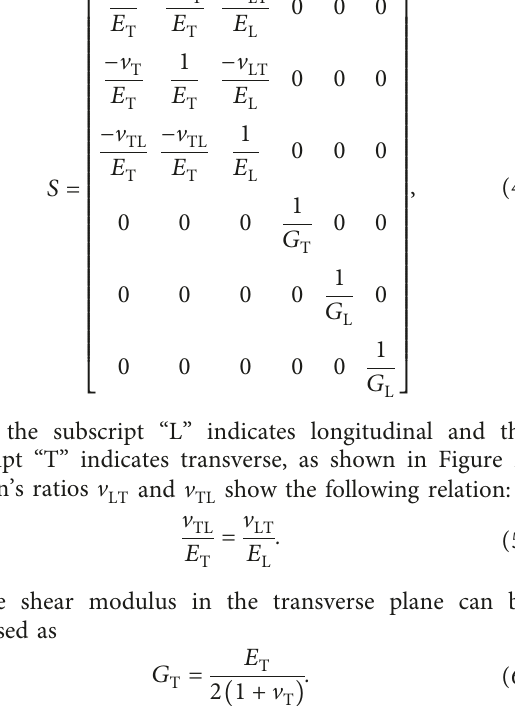
Figure 1: The coating-substrate composite